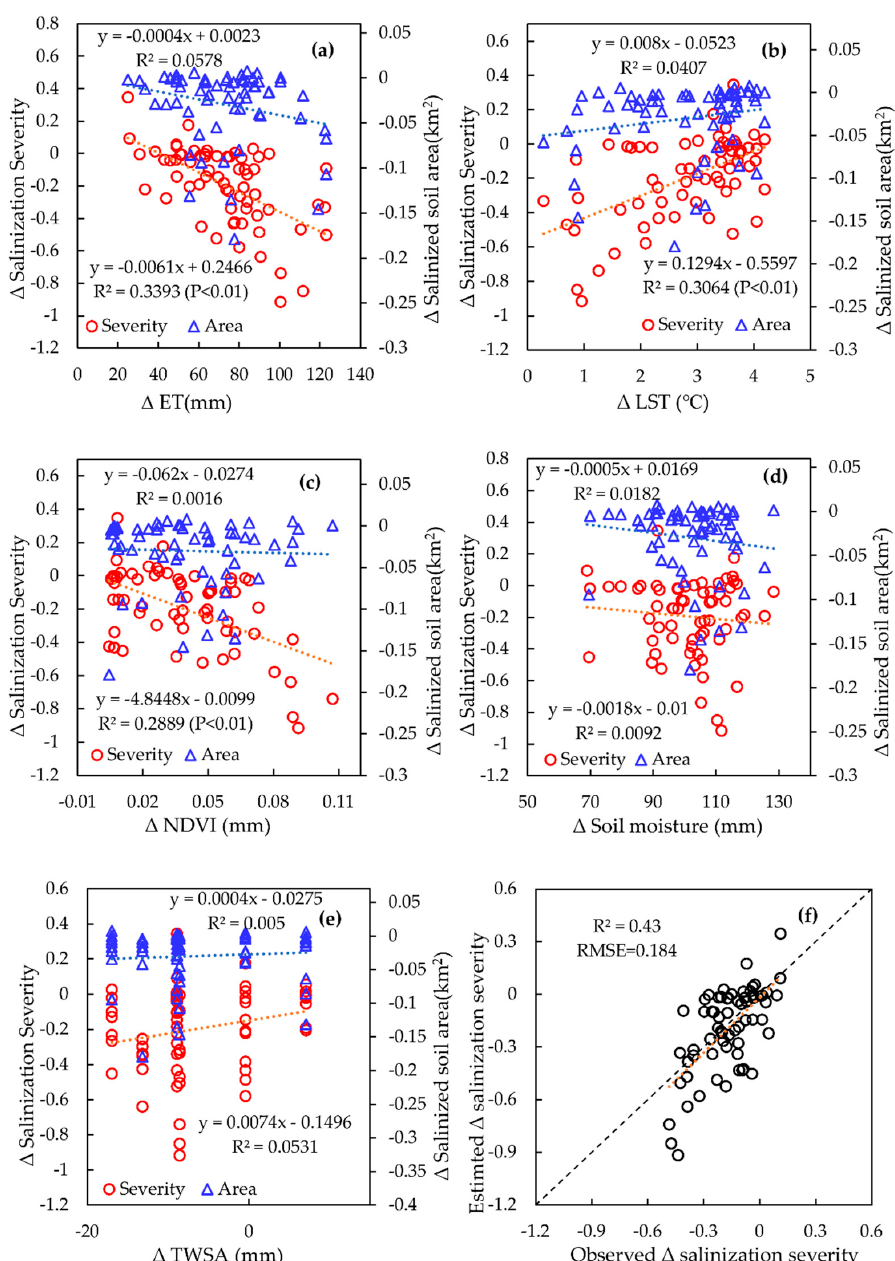
Figure 10. Linear relationships between the variations of soil salinization indicators (salinization severity and salinized soil area) and eco-hydrological parameters. ( a ) ET, ( b ) LST, ( c ) NDVI, ( d ) SM, ( e ) TWSA, ( f ) accuracy validation of the multiple linear regression